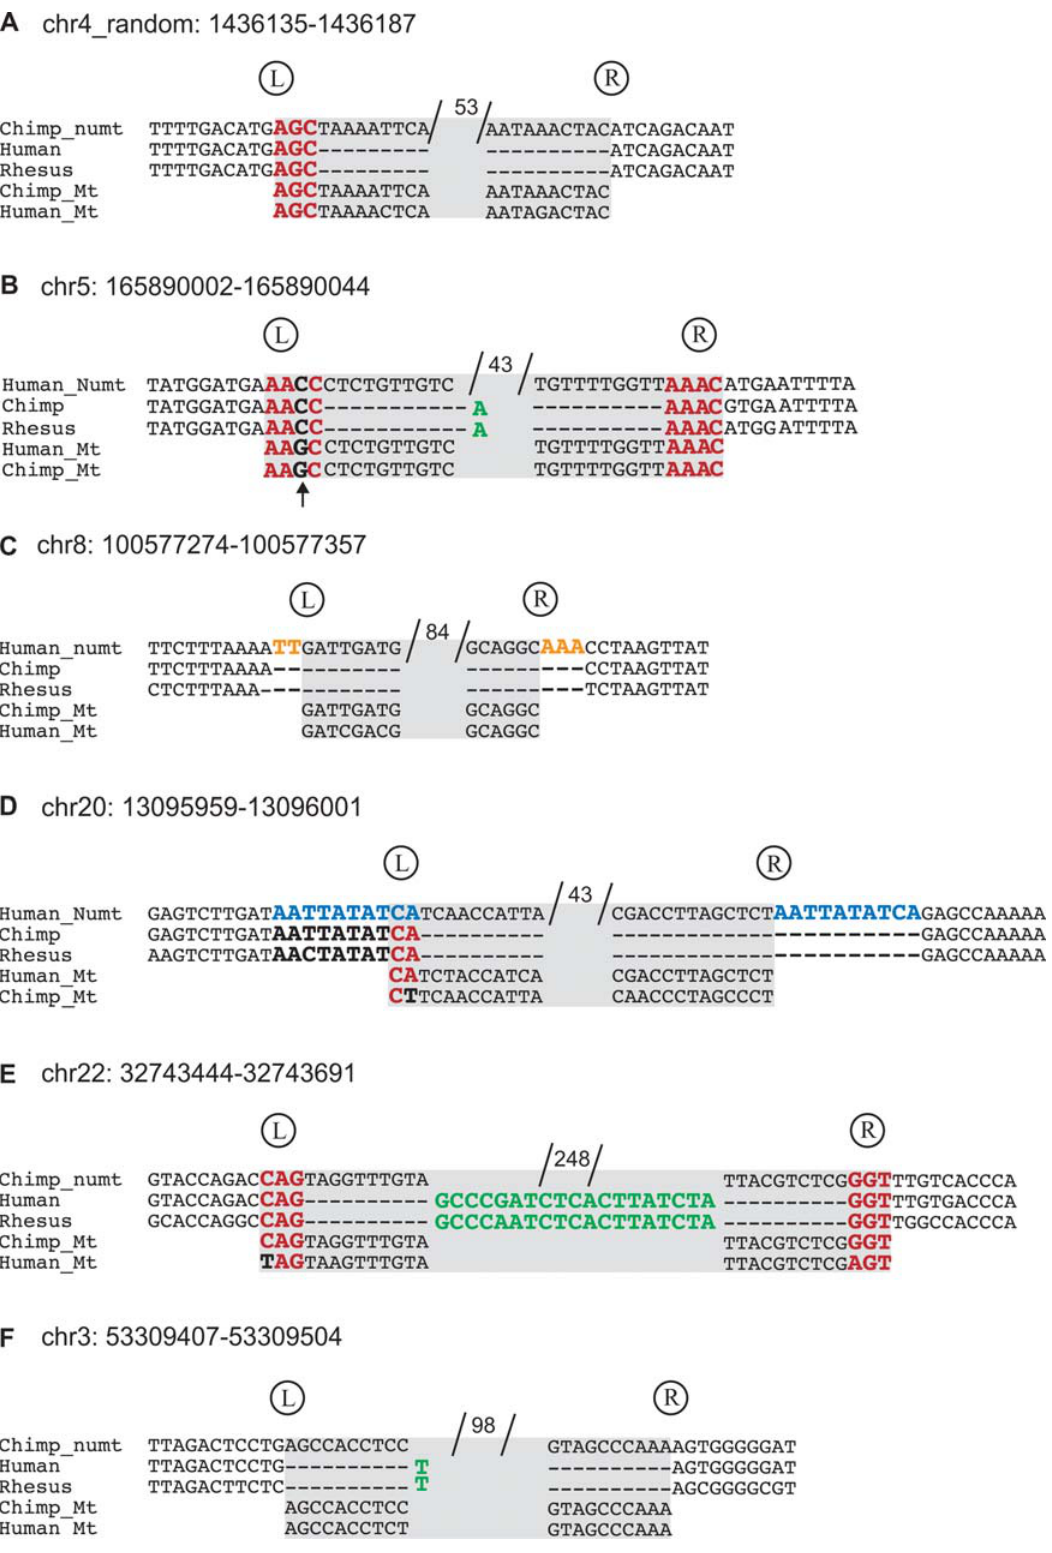
Figure 2. Common forms of numt -mediated NHEJ. Each alignment includes a human or chimpanzee locus with a numt as well as the corresponding nuclear sequence in the sister taxon and rhesus sequences. The mitochondrial sequences from human and chimpanzee are also indicated. (A) Numt insertion involved microhomology of AGC at the left fusion point (shown in red) and blunt-end repair at the right fusion point [id=97]. (B) The numt locus involved imperfect microhomology at the left fusion point and continuous microhomology at the right fusion point. The position marked with an arrow has C in the nuclear genomes but G in the mitochondrial genomes. One base was deleted (green) [id=16]. (C) Numt